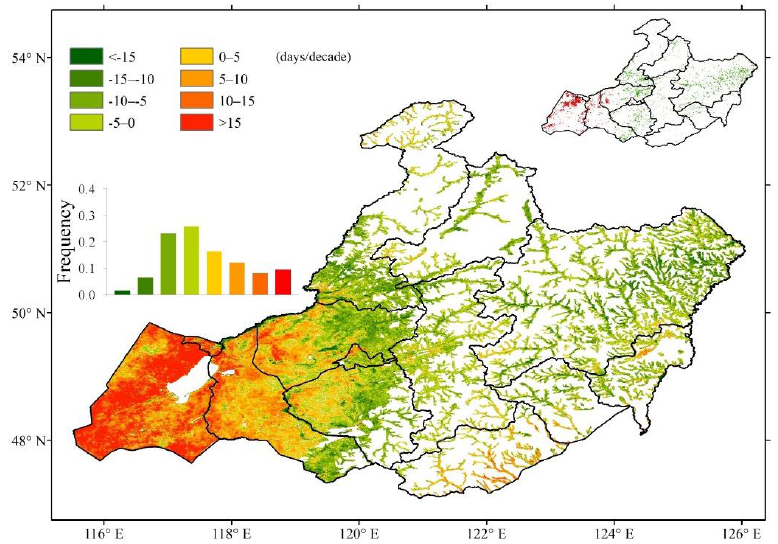
Figure 9. Spatial pattern of the temporal trends in green-up dates (in days per decade) between 2001 and 2015. The inset shown at the top-right of the figure indicates pixels with a significant ( p < 0.05) increase (red) or decrease (green). The middle-left inset shows the frequency distribution of trends corresponding to the values indicated by the map legend.